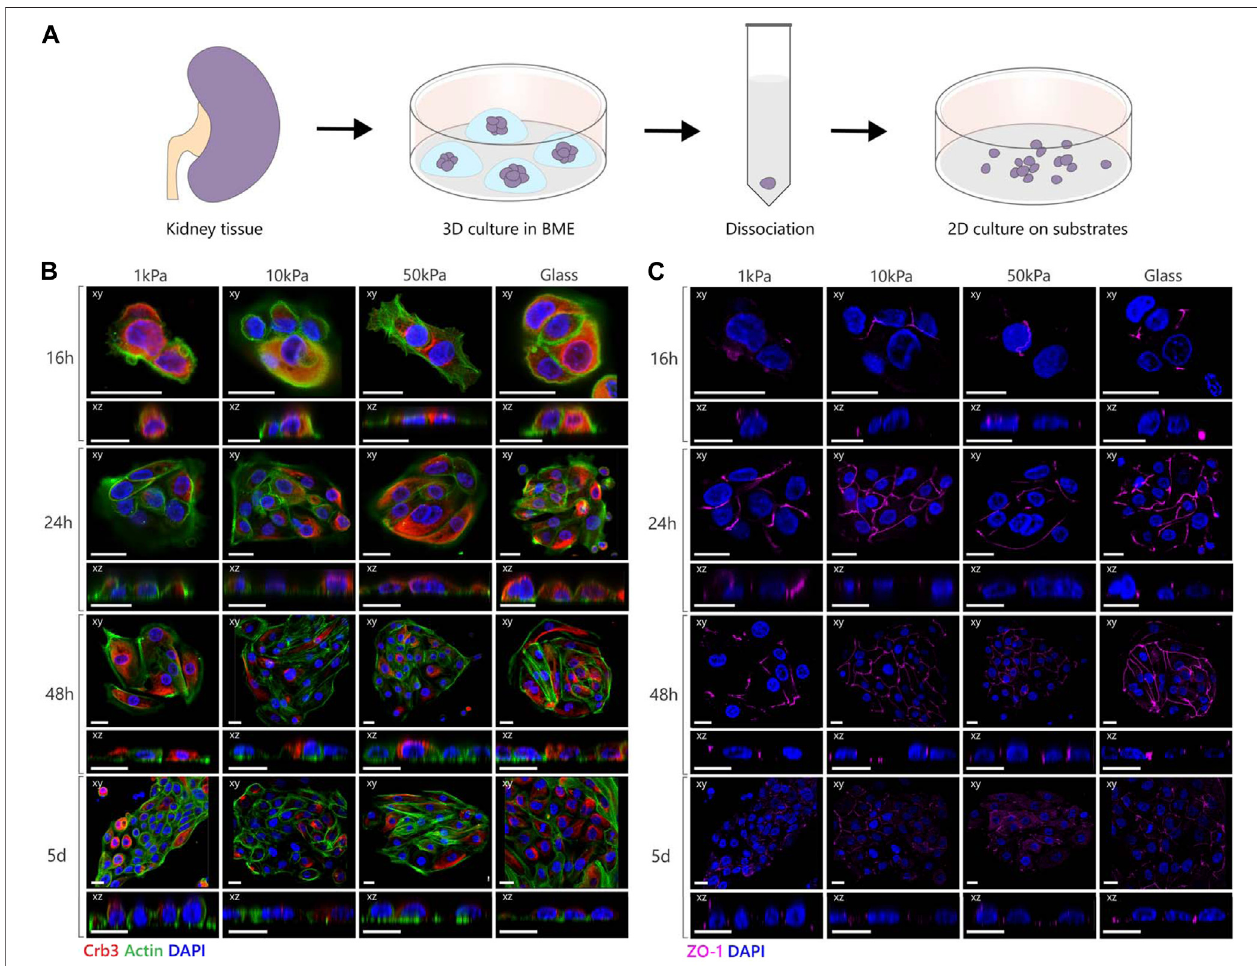
FIGURE 3 | Polarization and junction formation of tubuloid-derived cells on substrates with different elastic moduli. (A) Schematic image depicting the culture of tubuloid-derived cells isolated from cortical human kidney. (B,C) Representative fl uorescent images of tubuloid-derived cells cultured on PAA substrates with an elastic modulus of 1, 10 and 50 kPa or on glass substrates. The cells were stained for either Crb3 (red), actin (green) and nuclei (blue) or for Zona Occludens 1 (magenta) and nuclei (blue). Confocal sections are shown in both xy (top) and xz (bottom) direction. Scale bars are 20 µm.